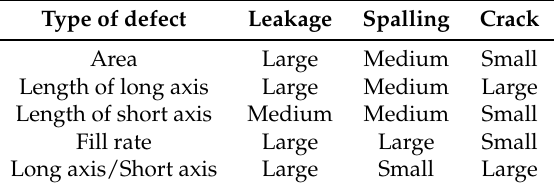
Table 1. Features of different types of